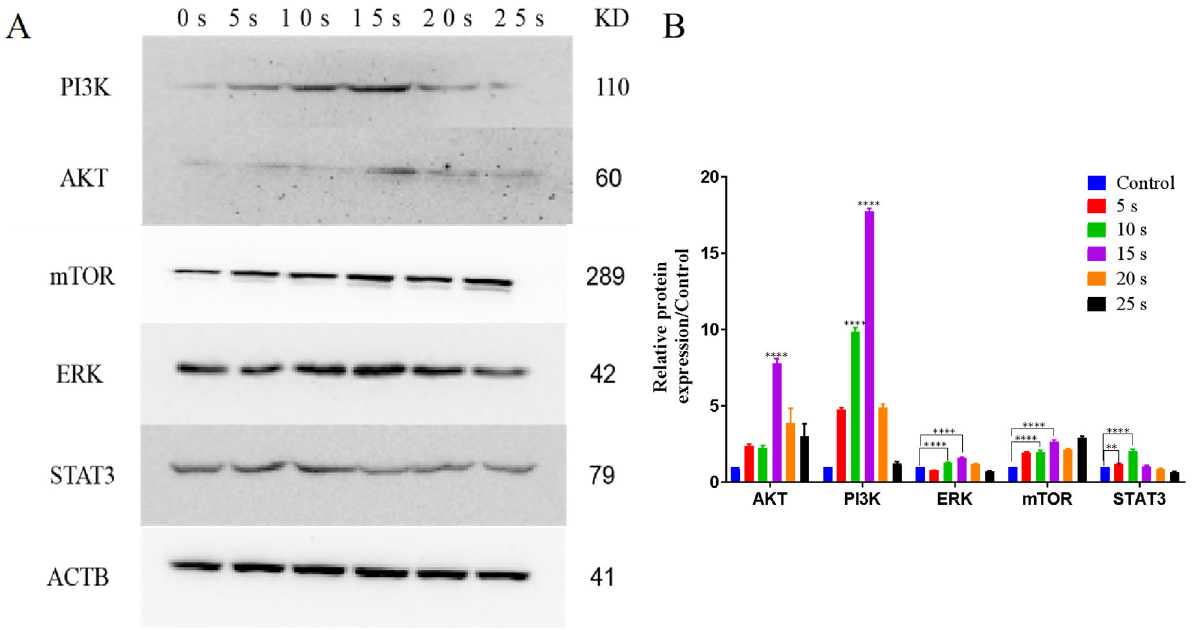
Figure 7. NTP activated the PI3K/AKT and STAT3 pathways in HaCaT cells. ( A ) The expression of PI3K, AKT, mTOR, Cyclin D1, ERK, and STAT3 were determined by WB. ( B ) The quantification by measuring the protein expression with Photoshop software (version 20.0.4). Data represent the mean ± SD of three independent experiments. ** p < 0.001, **** p < 0.0001 with ANOVA compared with the control.